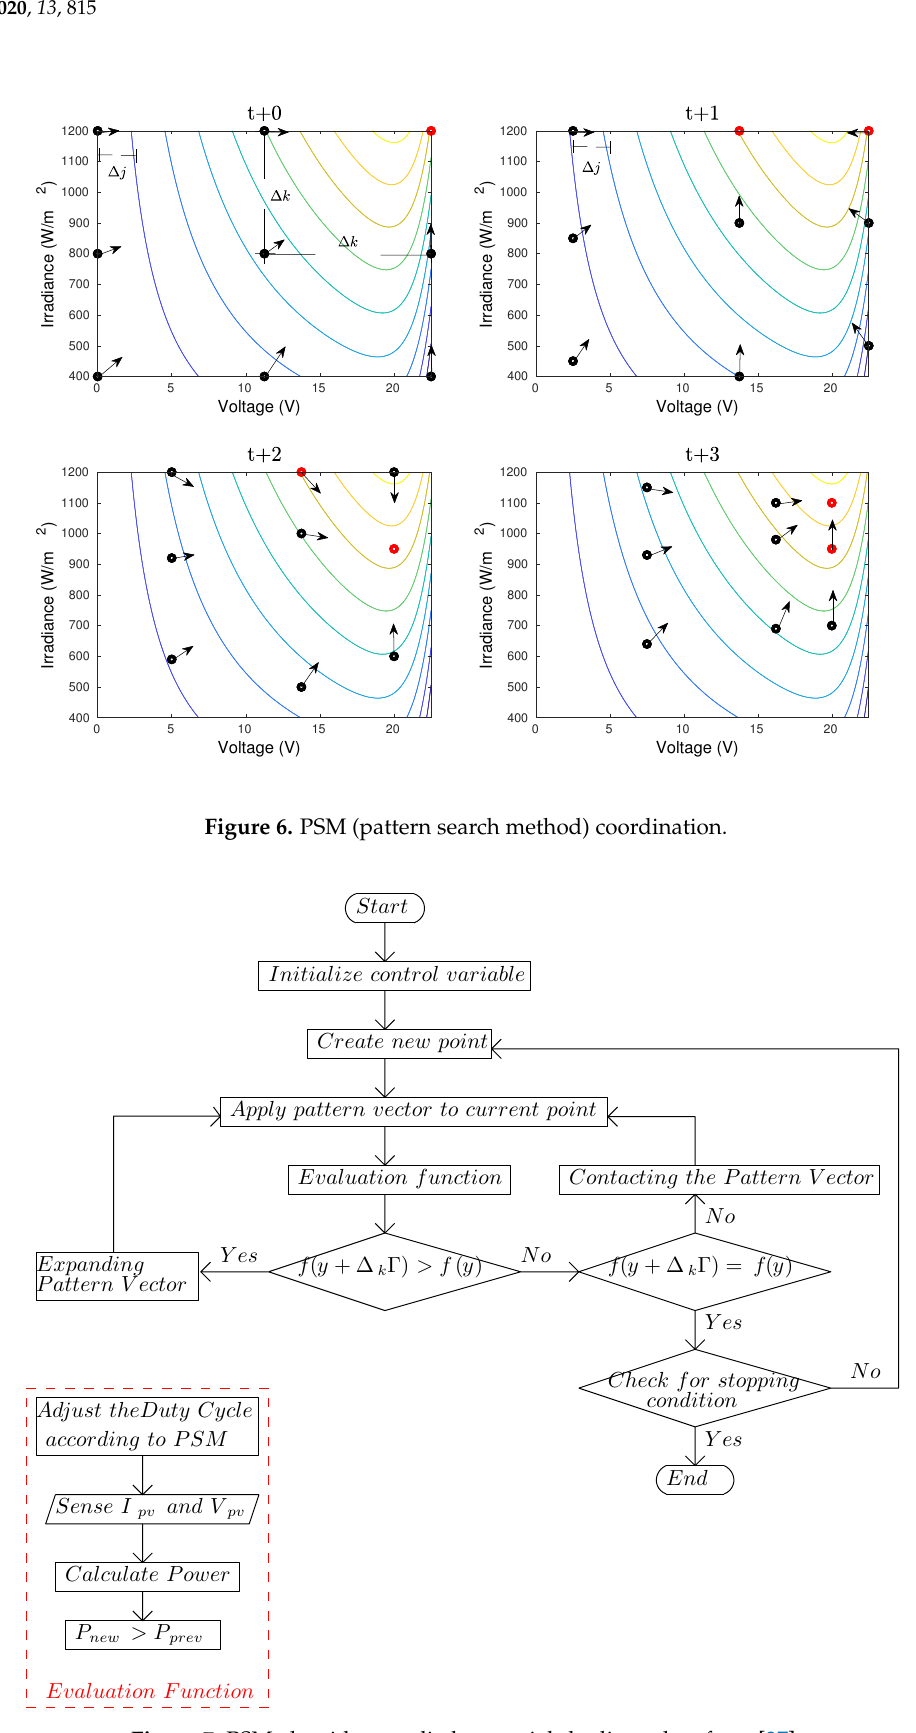
Figure 7. PSM algorithm applied to partial shading taken from